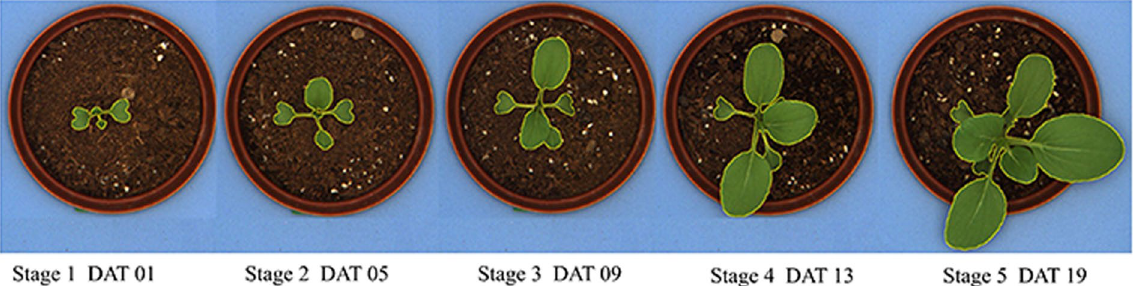
Figure 6. Pakchoi seedling appearance at five growing stages. DAT: days after